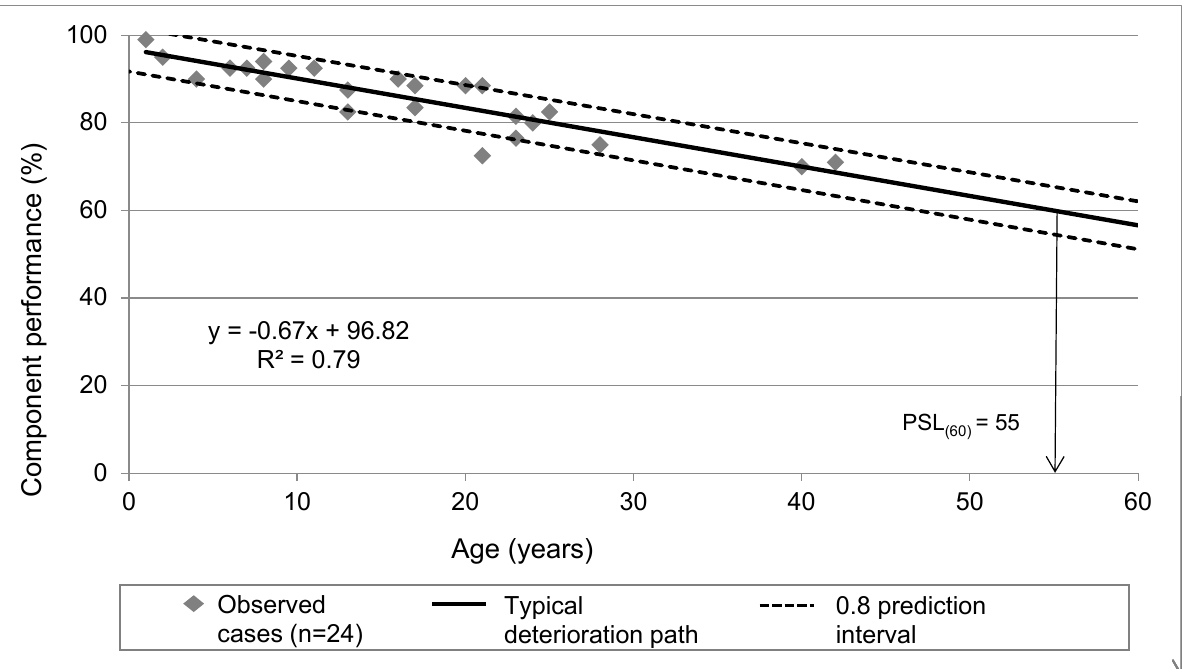
Figure 7. Deterioration pa tt ern of exterior dry- fi xed stone claddings in marine environment service conditions. Table 8. Life expectancy limited coefficient, LELC of stone cladding exposed to marine environment, according to Equation (1).